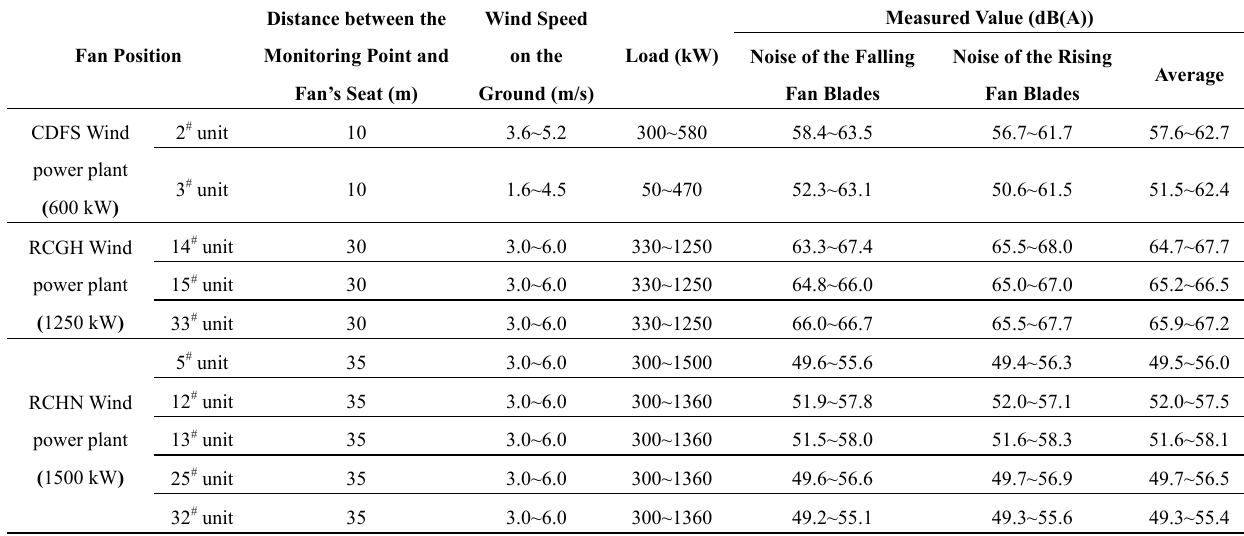
Table 2. Monitoring results for wind farm noise for power plants along the coast in Shandong